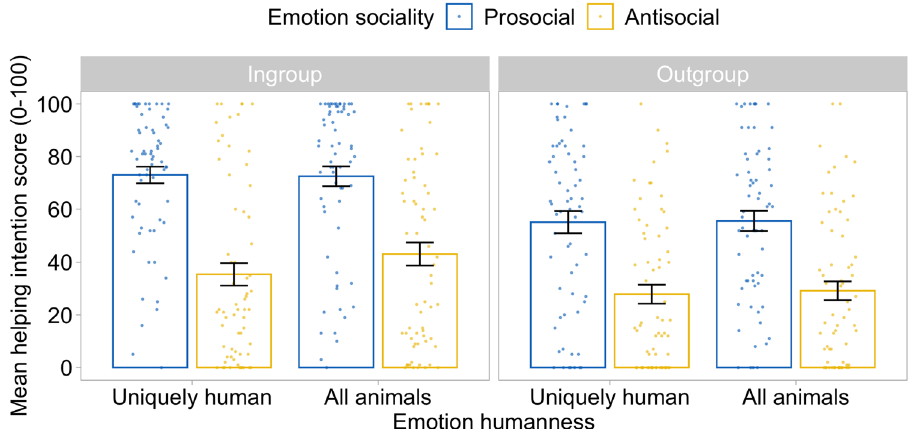
Figure 4. Intergroup helping intentions are affected by the sociality, not the humanness, of emotion expressions. Error bars represent standard